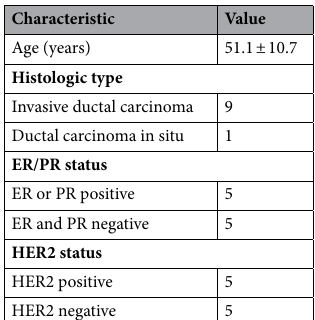
Table 1. Study participants and breast cancer characteristics. Age and lesion size are shown as mean data ± standard deviation. Unless otherwise indicated, data are number of cancers. ER estrogen receptor, PR progesterone receptor, HER2 = human epidermal growth factor receptor 2.